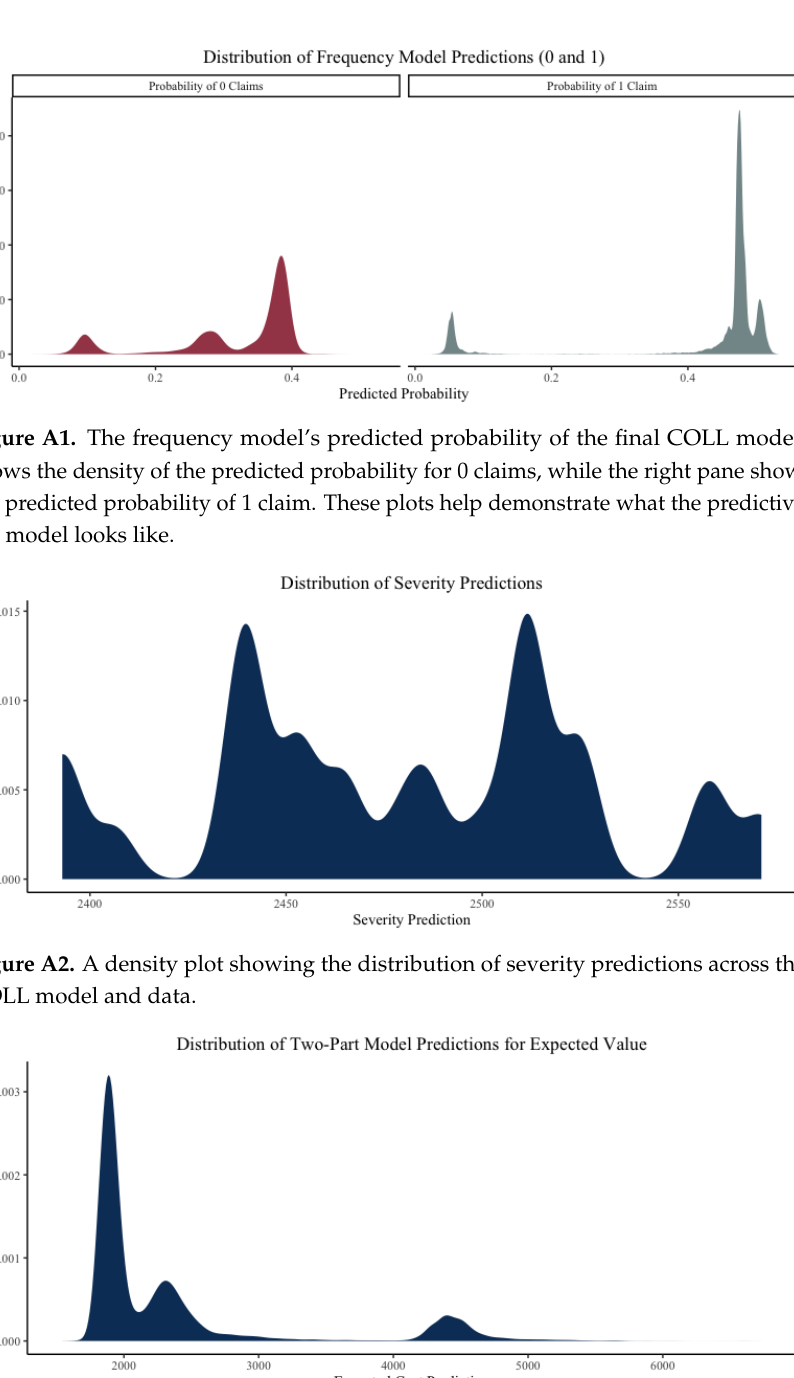
Figure A3. A density plot showing the expected value predictions when both the frequency and severity model parts are combined for the COLL data, as predicted on the test set. This corresponds to the premium when adjusted for the exposure of the